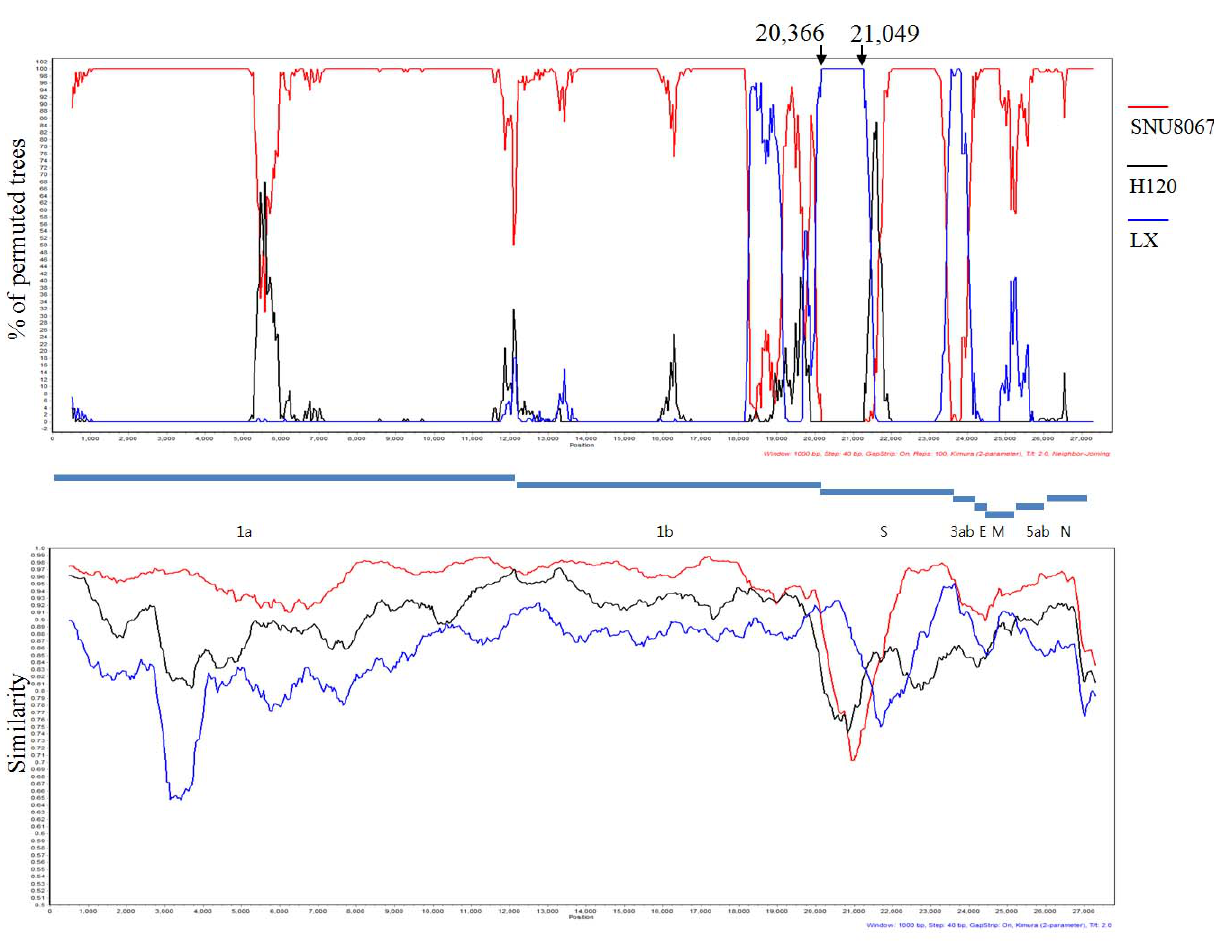
Figure 2. Computational recombination analysis of the KM91, SNU8067, H120, and LX4 strains. The recombination breakpoints were detected by the RDP program (version 4.5) [16] and the similarity and percent of permuted trees were calculated by the SimPlot program (version 3.5.1) [17].